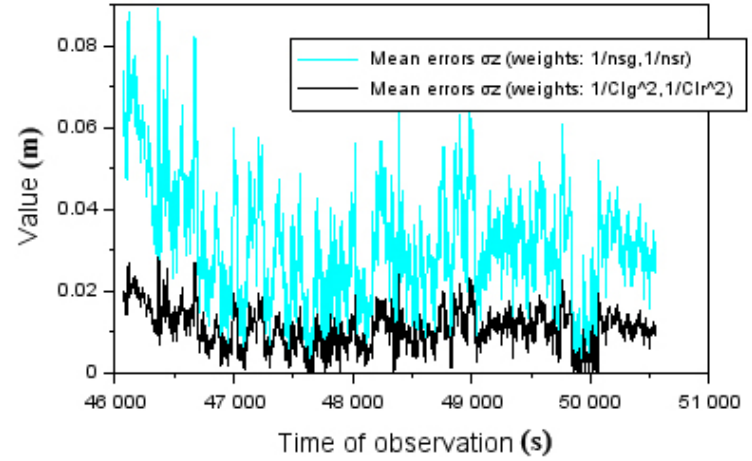
Figure 10. Mean errors σ z along the Z -axis.